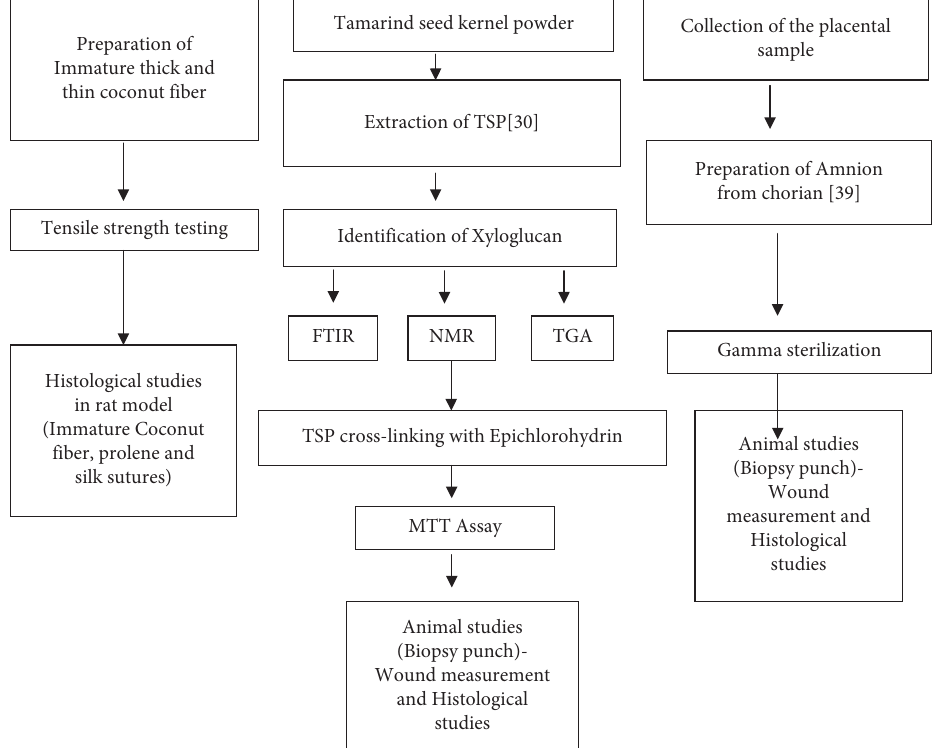
Figure 1: Combination therapy for cut and open wounds. TSP: tamarind seed polysaccharide; FTIR: Fourier-transform infrared spec- troscopy; NMR: nuclear magnetic resonance; TGA: thermogravimetric analysis; MTT: 3-(4,5-dimethylthiazol-2-yl)-2,5-diphenylte- trazolium bromide.